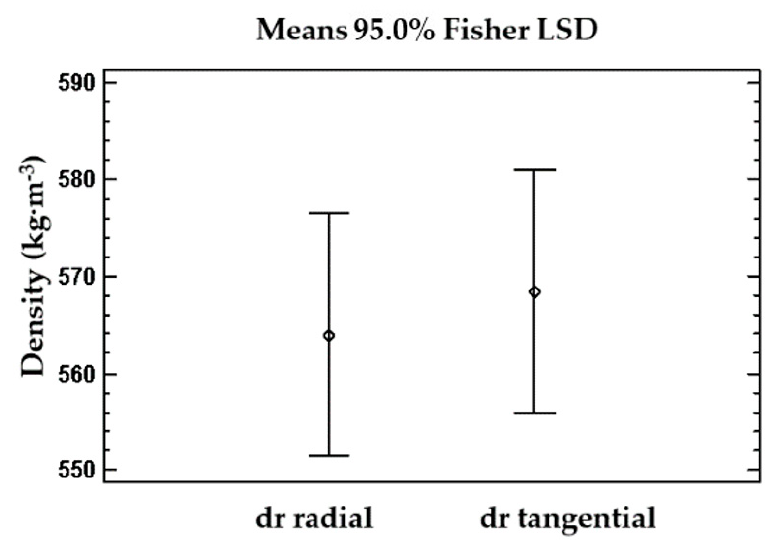
Figure 3. Means plot of density of drilling residues(dr) from radial and tangential holes.